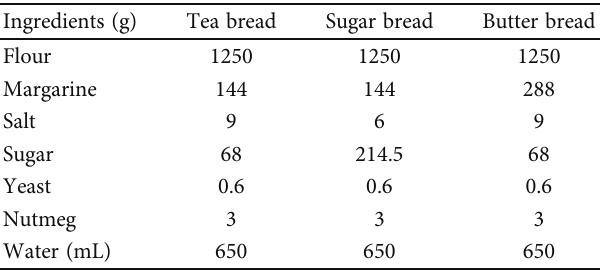
Each type of bread had fi ve WF:TNF substitution levels, Table 1: Recipe for tea bread, sugar bread, and butter bread [15].